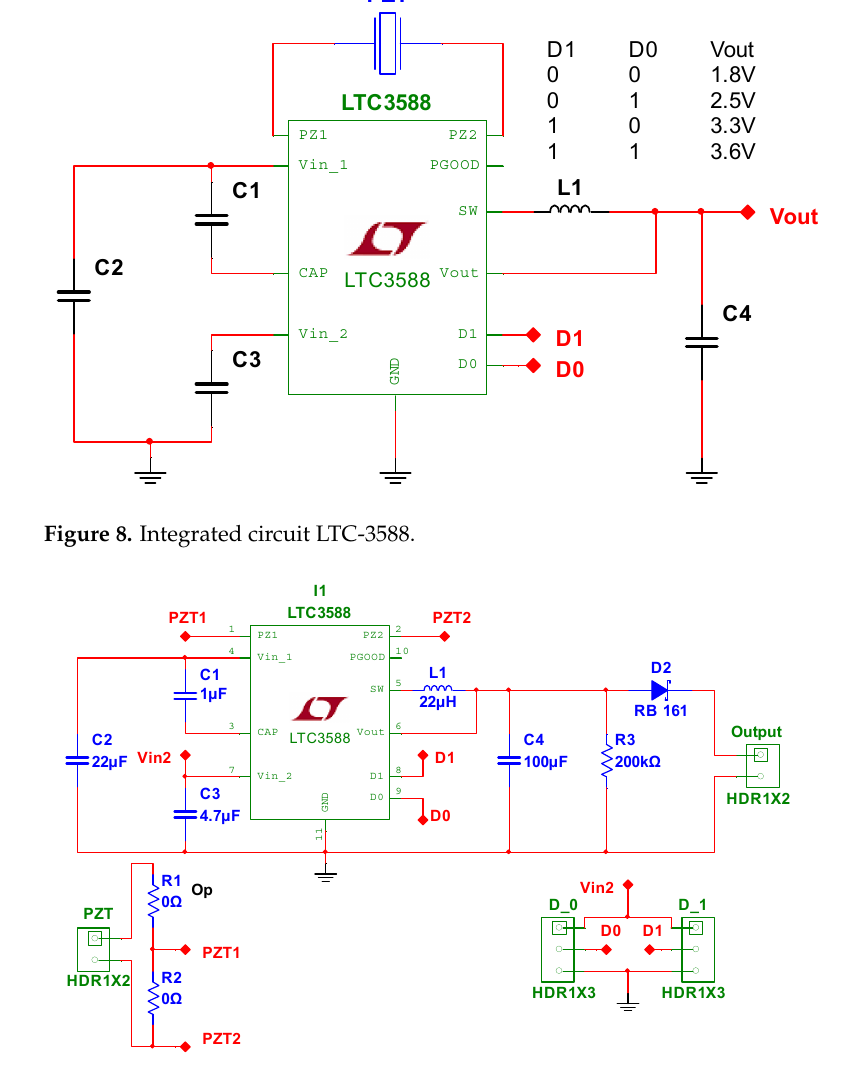
Figure 9. Diagram used for the development of the energy harvester module.